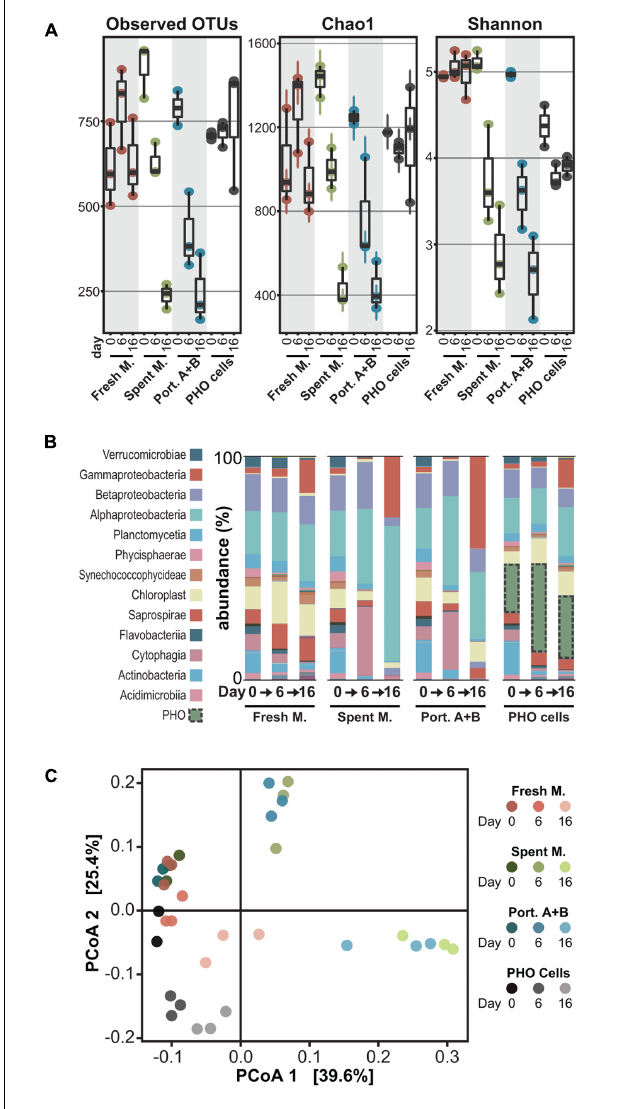
FIGURE 3 | Analysis of 16S rDNA amplicon metagenomics data for the microbial communities at different time points following exposure. (A) Box-whisker plots depicting alpha diversity indexes for each of the microbial communities analyzed; (B) Community compositions (relative abundances, averaged) at the class/subclass level; (C) Principal coordinates analysis visualization of the weighted UniFrac distances between the microbial